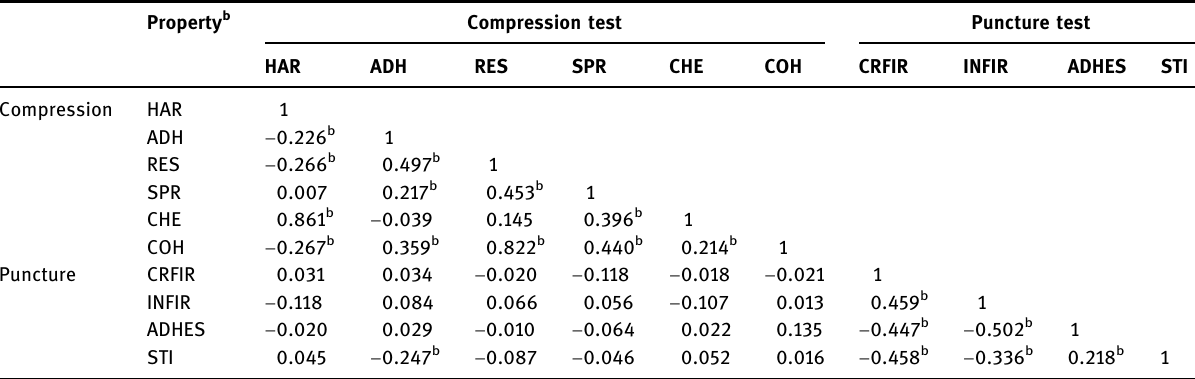
Table 1: Pearson correlations between the textural properties Property